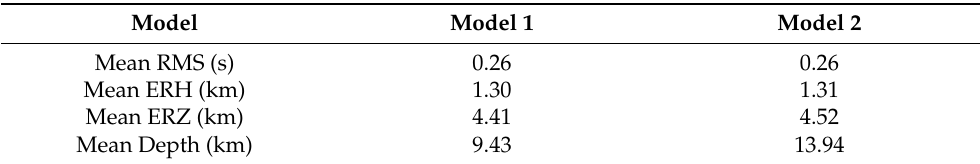
Table 1. Comparison of the error statistics between Model 1 [28] and Model 2 [29] for the Arkalo- chori seismic sequence.